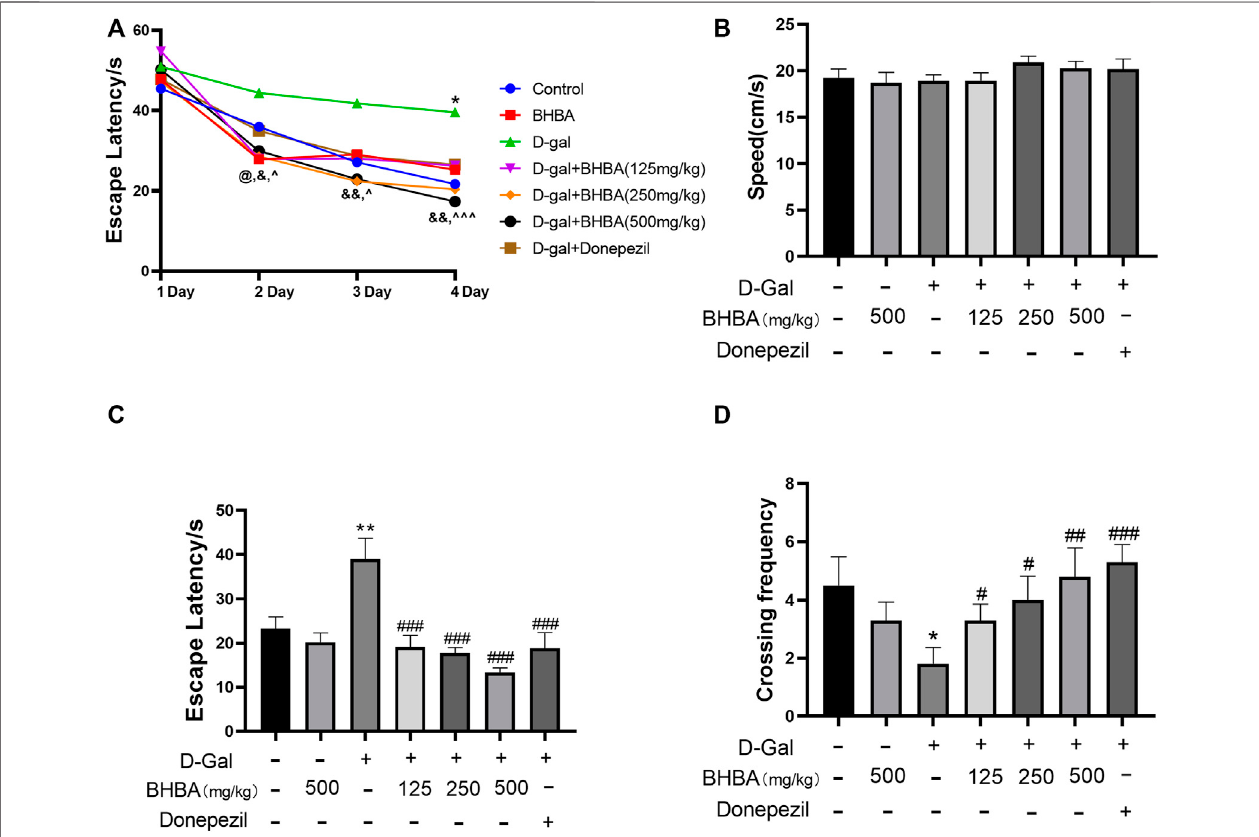
FIGURE1| EffectsofBHBAonbehaviorinthewatermazetestinD-gal-inducedmice. (A) Escapelatencyduringtraining. (B) Swimmingspeedonthe fi fthday. (C) Escapelatencyonthe fi fthday. (D) Crossingfrequencyonthe fi fthday.D-gal:180 mg/kg;BHBA:125,250,and500 mg/kg,respectively;donepezil:3 mg/kg,n (cid:1) 8 – 10. Compared with the control group, * p < 0.05, ** p < 0.01; compared with the D-gal group, # p < 0.05, ## p < 0.01, ### p < 0.001. D-gal + BHBA (125 mg/kg) compared withtheD-galgroup,@ p < 0.05,D-gal+BHBA(250 mg/kg)comparedwiththeD-galgroup,& p < 0.05,&& p < 0.01,D-gal+BHBA(500 mg/kg)comparedwiththe D-gal group, ^ p < 0.05, ^^^ p <